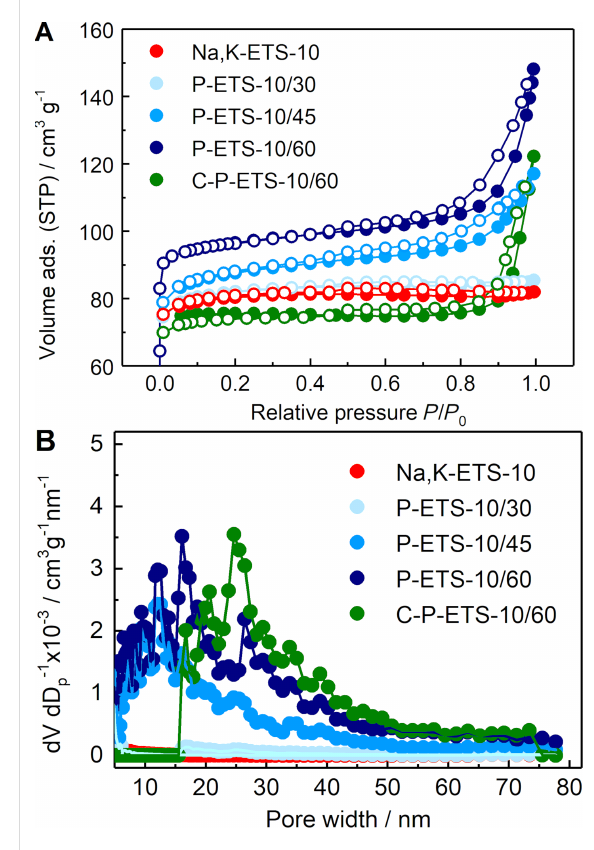
Figure 9: (A) Nitrogen adsorption and desorption isotherms of titanosil- icates treated with H 2 O 2 for 30 min (light blue), 45 min (blue) and 60 min (dark blue) and of the latter after calcination (green). The sorp- tion isotherm of as-synthesized Na,K-ETS-10 (red) is shown for com- parison. (B) Calculated pore width distributions using the NLDFT.